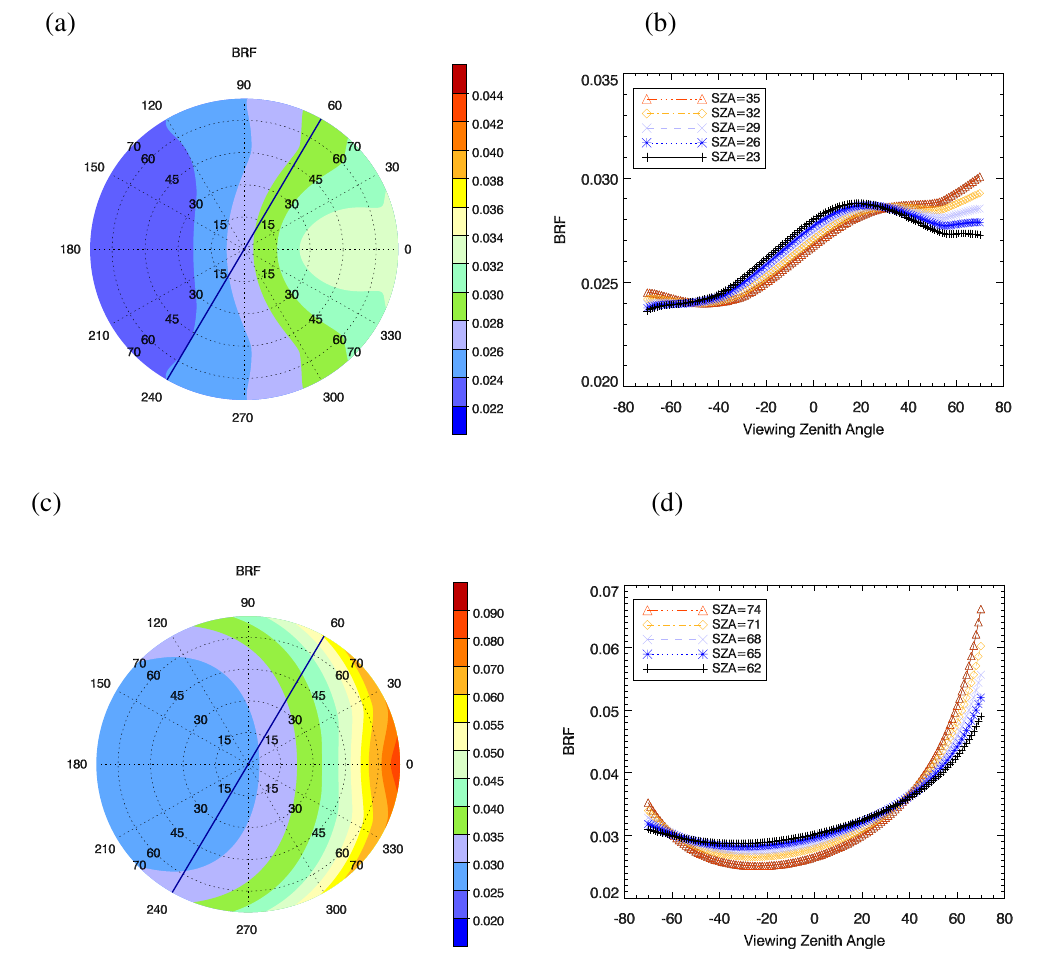
Fig. 5. Left panels: polar plots of BRF for a typical land surface and solar zenith angle scenario in July (a) and November (c) corresponding to cases A1 and A2 in Table 1, respectively. Right panels: variation of BRF along an OMI swath for the same cases in July (b) and November (d). The OMI swath is marked by dark blue lines in the left panels.